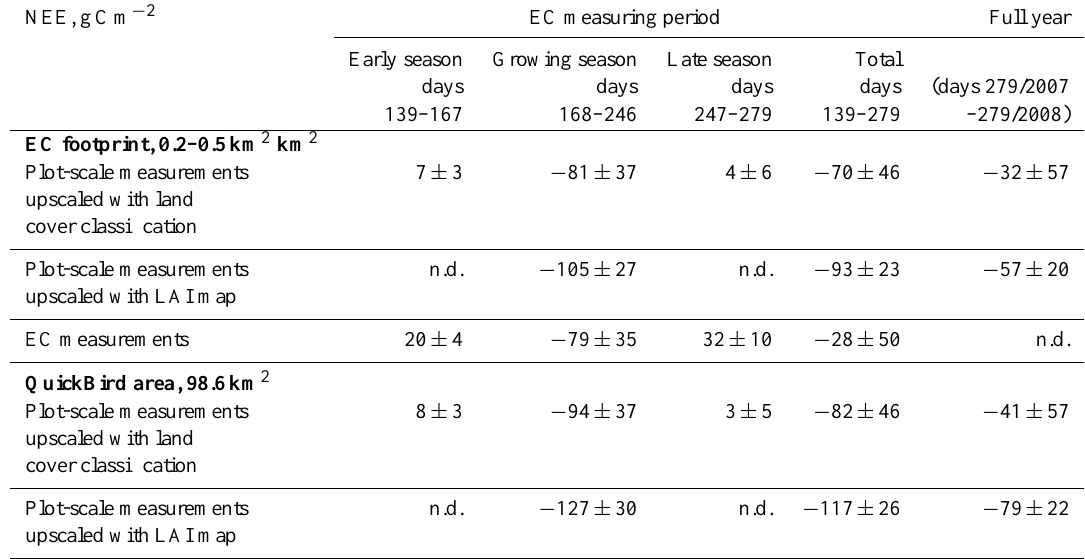
Table 5. Carbon dioxide balance for the intensive measuring period in 2008 and full year (October 2007–October 2008). Estimates for the EC footprint area are shown for different measuring techniques (plot-scale measurements = chamber technique and lake